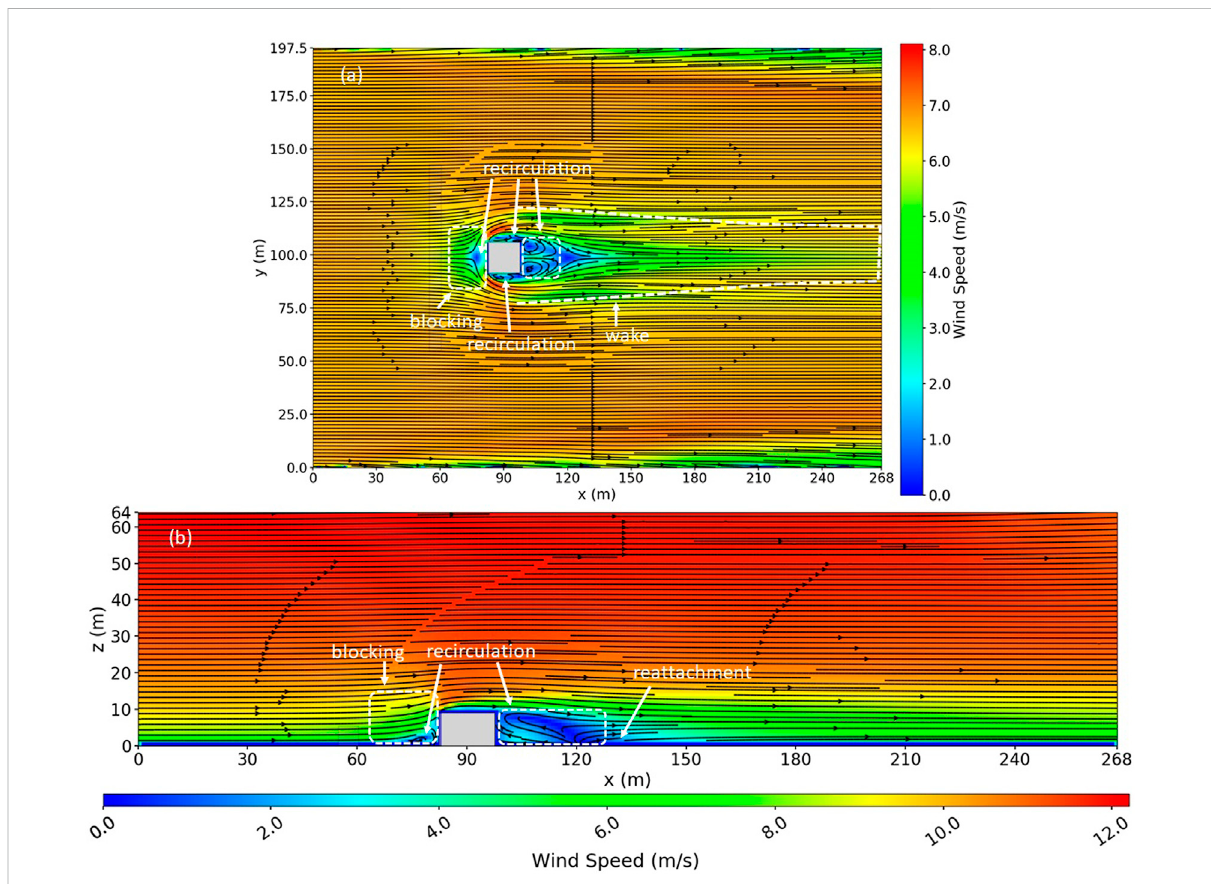
FIGURE 3 Simulatedwind fi eldoverahouse. (A) Topviewsliceatz=1.4 m,whichisthecellcenterofthesecond cellabovetheground. (B) Sideviewslice down the middle of the domain, through the middle of the house. The dashed lines delineate various fl ow features induced by the